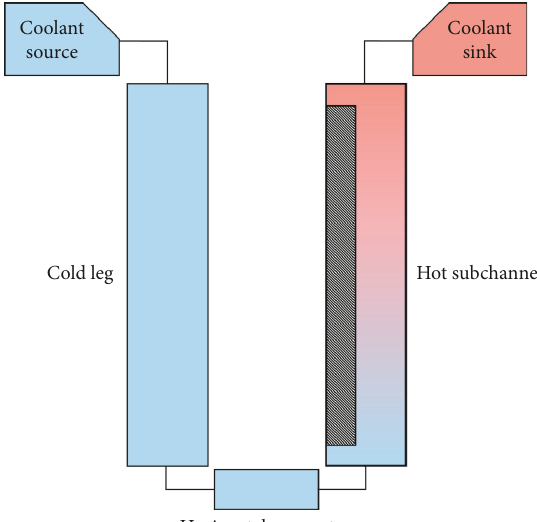
Figure 7: RELAP5/MOD3.3